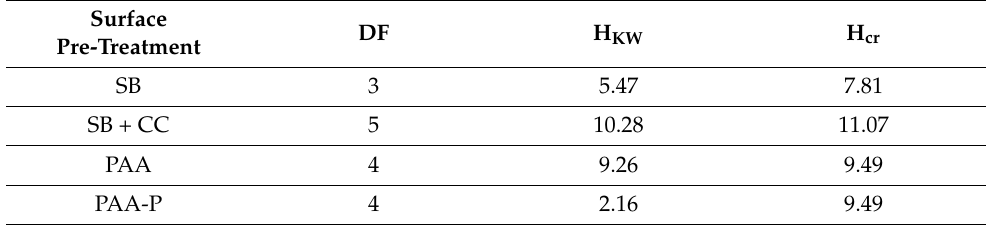
Table A3. Calculated Kruskal–Wallis statistics index and the respective critical value for the wear-out